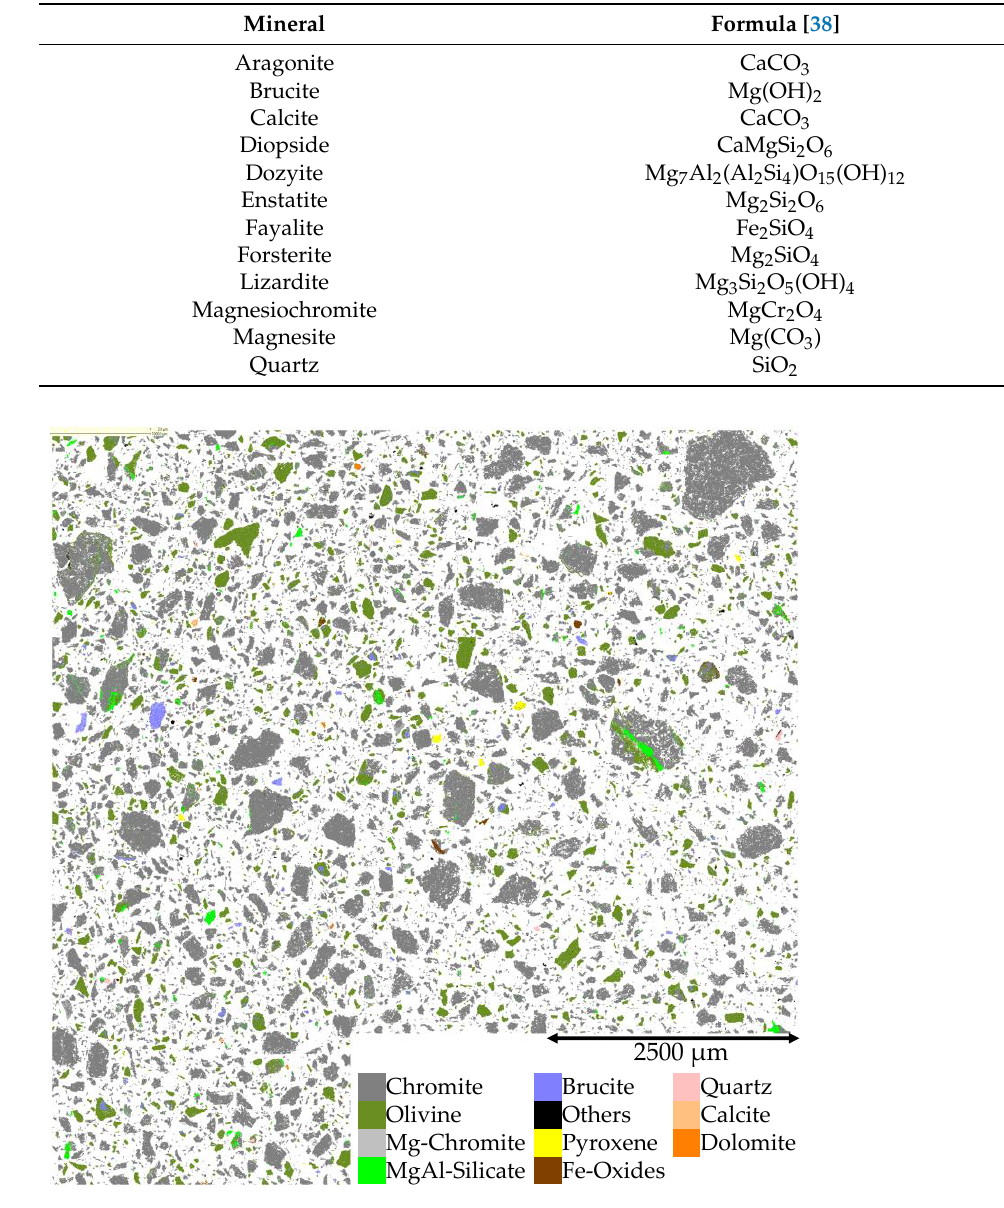
Figure 4. QEMSCAN ® false-color image of chromite sample.